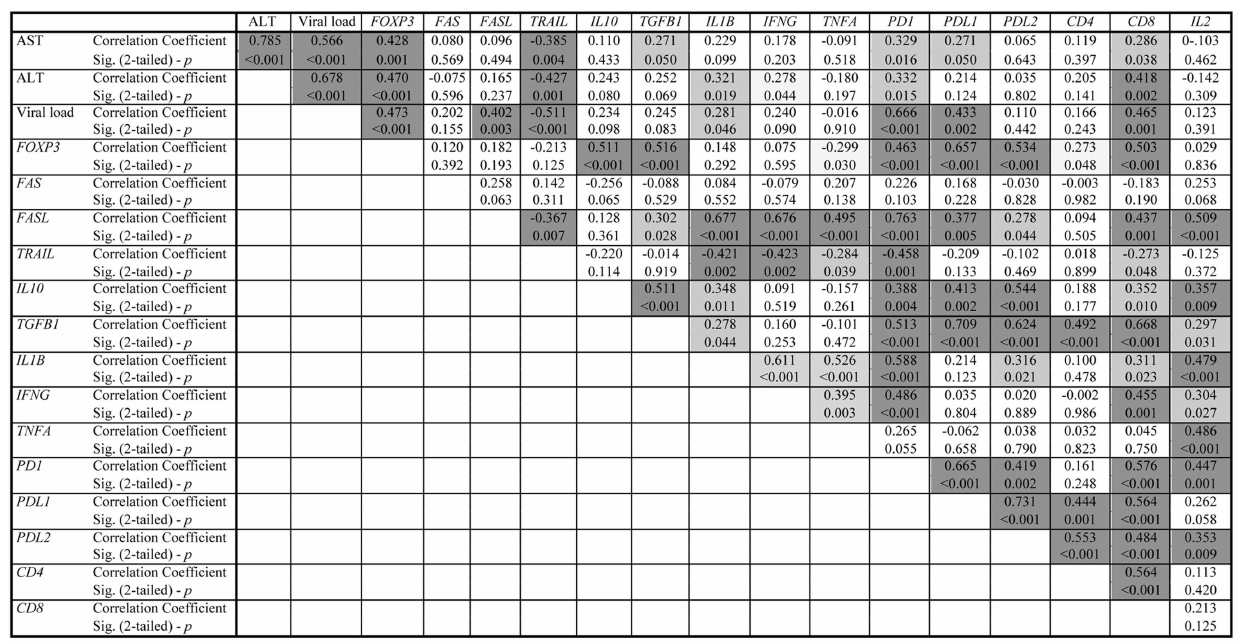
FIGURE 2 | Correlation data of chronic HBV hepatitis patients .The dark gray shadow refers to correlation significance p < 0.01 (two-tailed), while the light gray shadow refers to correlation significance p < 0.05